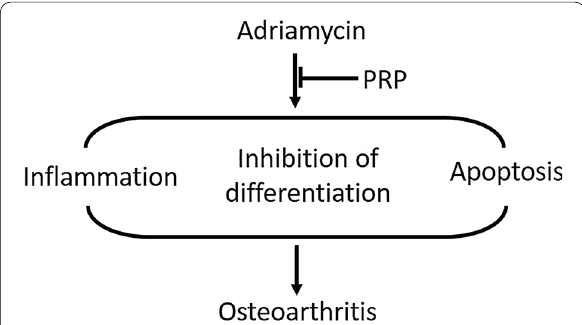
Fig. 6 Proposed mechanism of PRP inhibiting doxorubicin-induced osteoarthritis. PRP prevented arthritis by inhibiting doxorubicin-induced chondrocyte differentiation, apoptosis, and